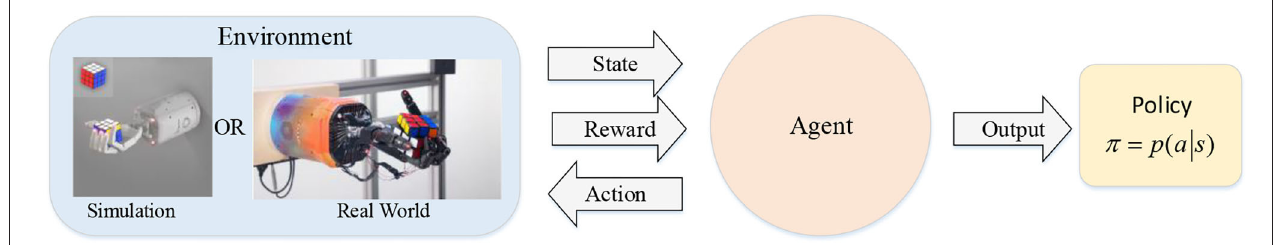
FIGURE 5 | Basic process of learning dexterous manipulation by RL from scratch (part of this picture comes from Open et al., 2019).